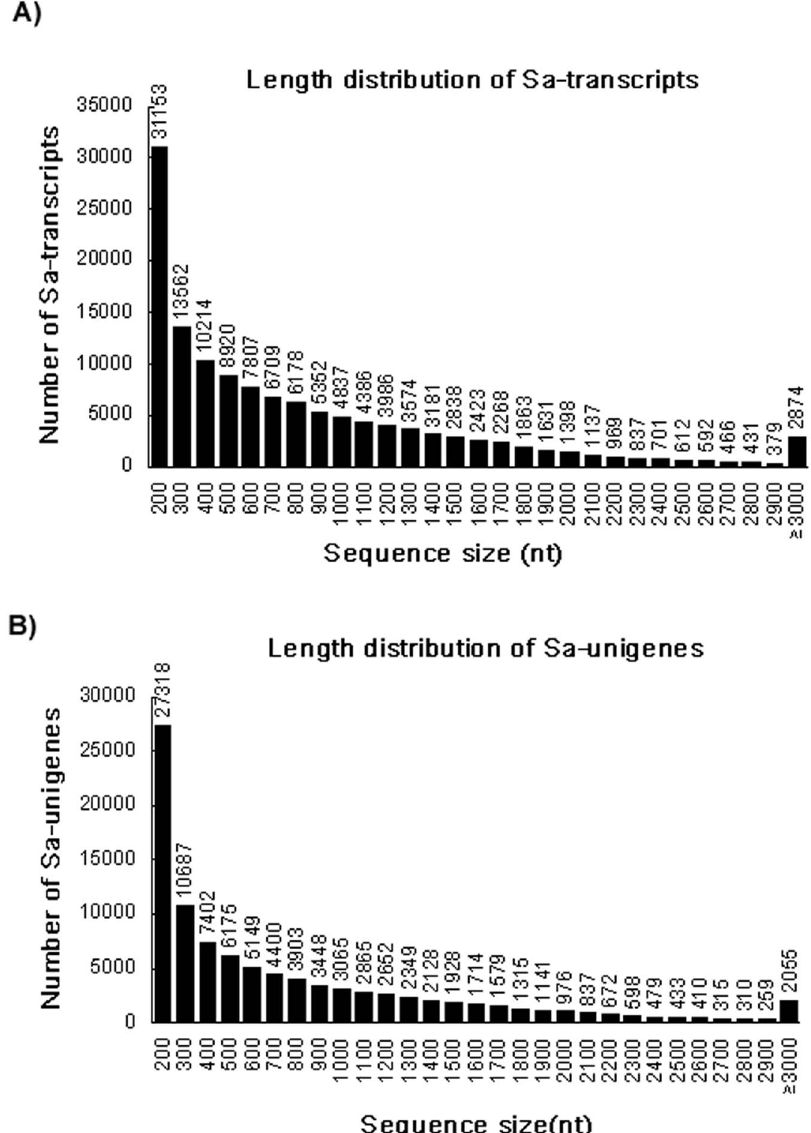
Figure 1. Size distribution of S.arvensis unigenes and transcripts.